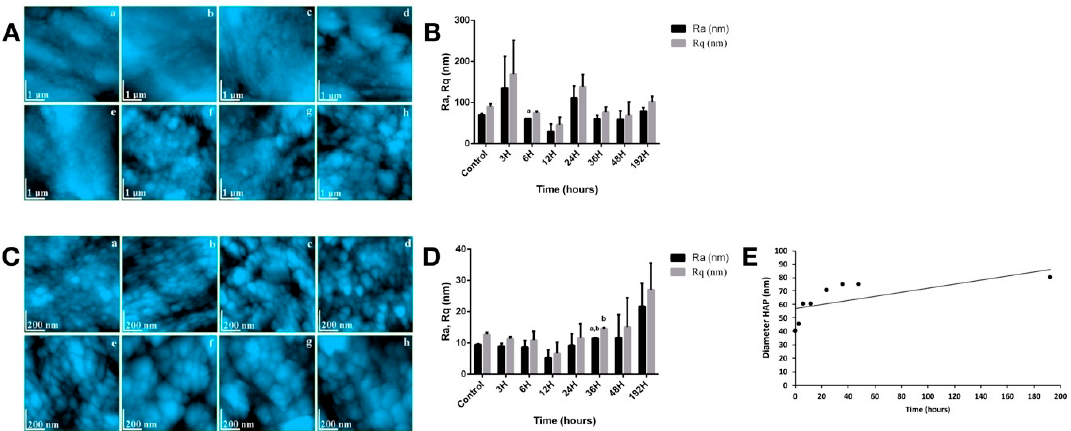
Figure 2. ( A ) Enamel fine microstructure: (a) CTR, (b) 3H, (c) 6H, (d) 12H, (e) 24H, (f) 36H, (g)